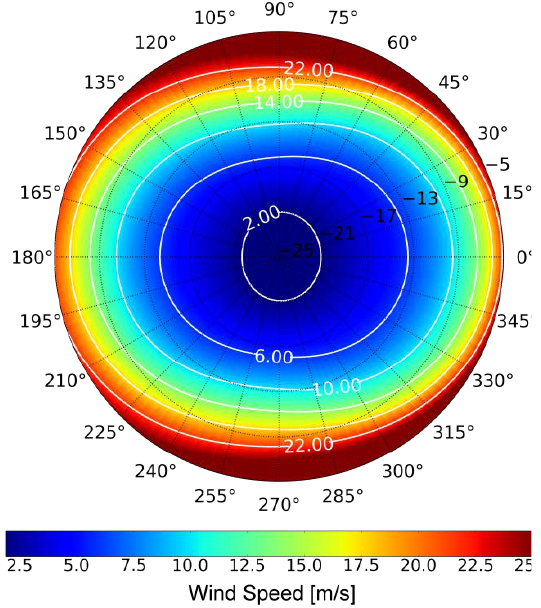
Figure 5. Wind speed derived from XMOD2 for an incidence angle of 35°. Radial axis/ black circles: NRCS in dB. Angle: Wind direction relative to antenna look direction at 0°. Color code: Wind speed in m/s.